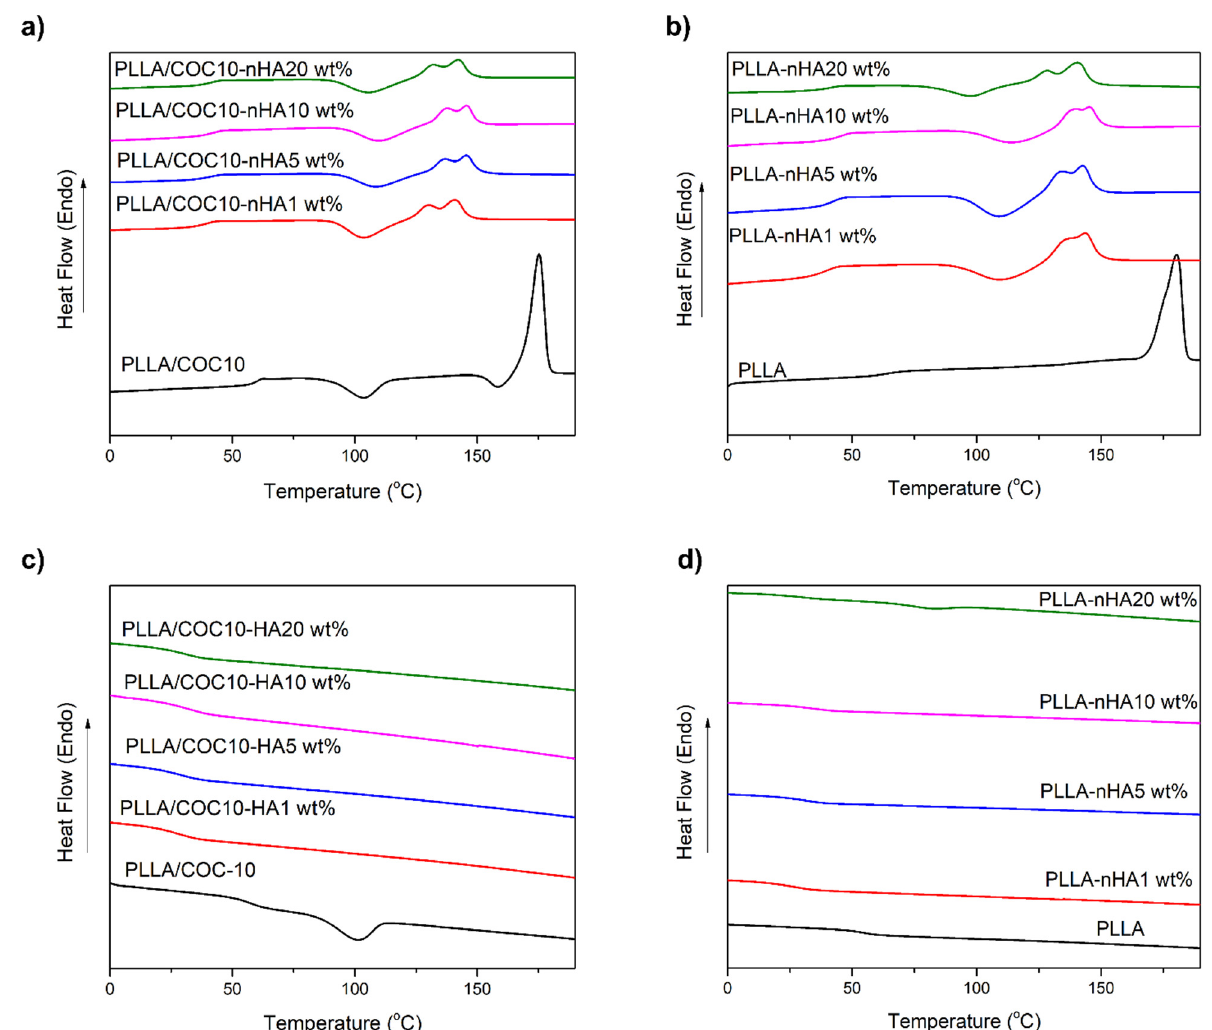
Figure 4. DSC of nanocomposites showed non-isothermal DSC thermograms at 10 °C per minute. PLLA/COC10-nHA ( a ) second heating scan ( c ) non-isothermal melt crystallization. PLLA/nHA ( b ) second heating scan ( d ) non-isothermal melt crystallization scan. Nanocomposites had nHA in 1 wt%, 5 wt%, 10 wt%, and 20 wt%.